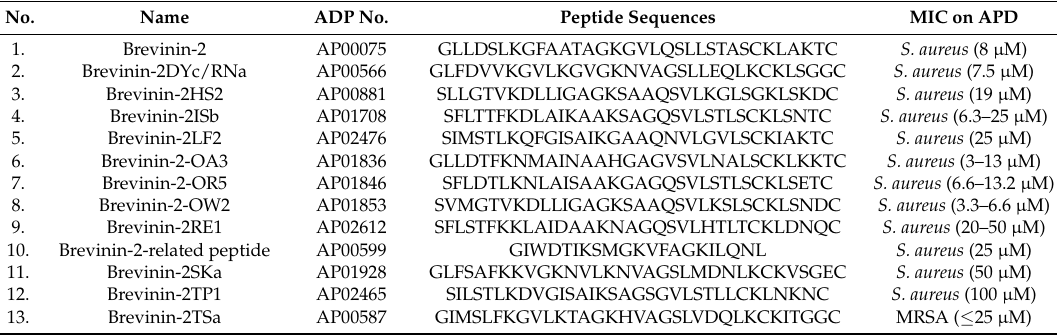
Table 1. Gram positive bacteria (G + ) effective Brevinin-2 family antimicrobial peptides used in the experiment. MIC: Minimum Inhibitory Concentration; APD: Antimicrobial Peptide